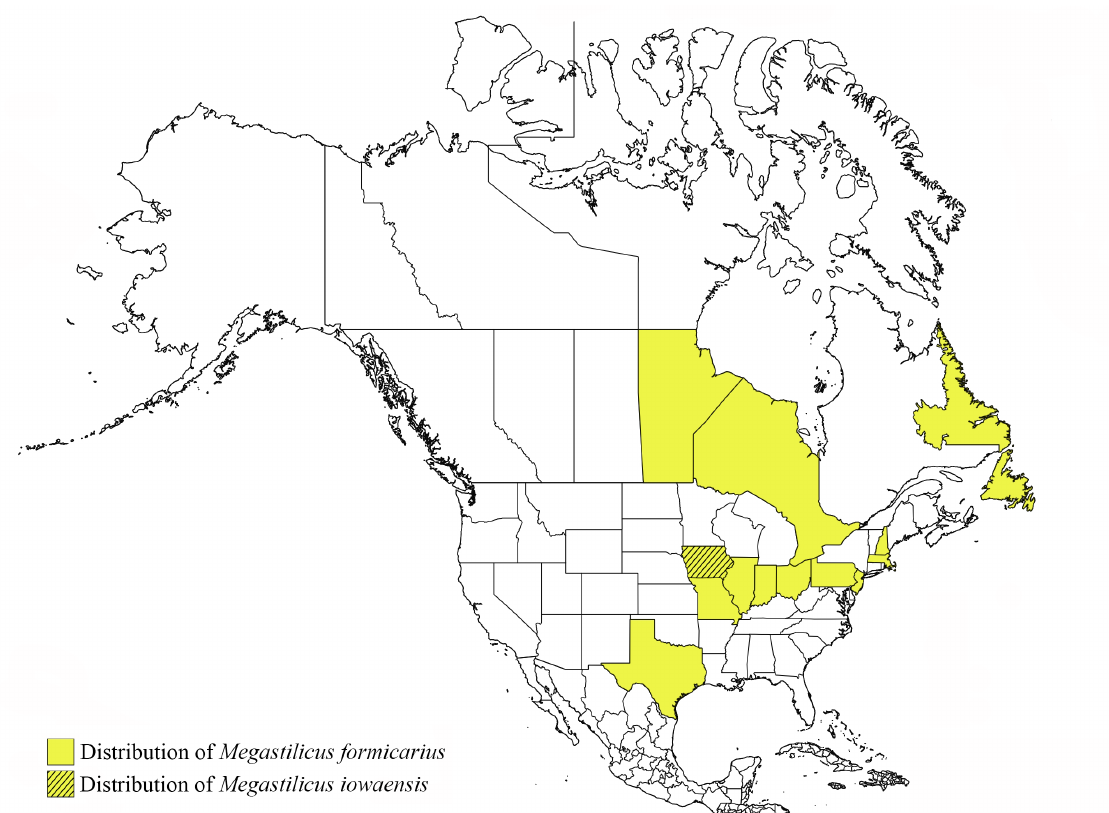
Fig. 3. Distribution of the genus Megastilicus Casey, 1889. Created with